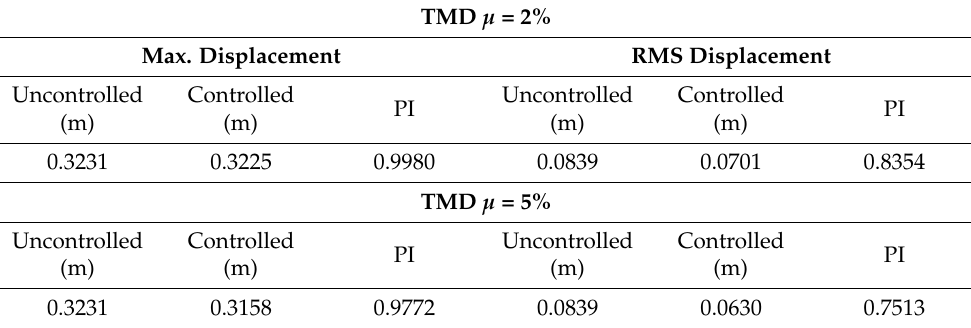
Table 8. Response parameters for the 32nd story of the structure subjected to San Fernando earth-